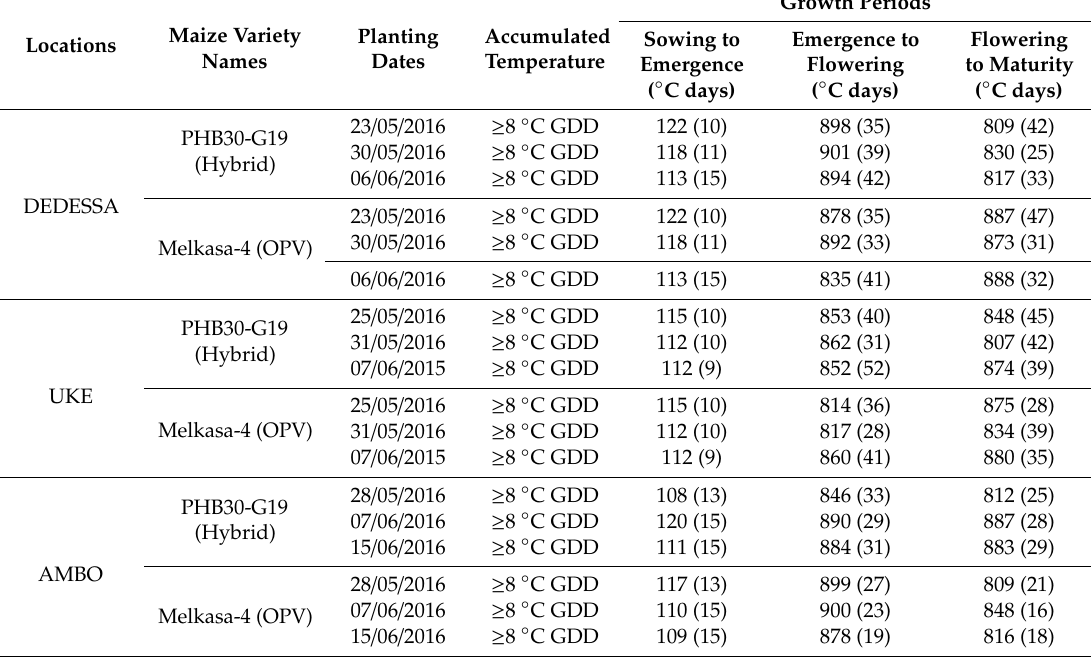
Table 1. Values of ≥ 10 ◦ C accumulated temperature and growing degree day (GDD) requirements during di ff erent growth periods with 3 planting dates for 2 maize varieties (PHB30-G19 and Melkasa-4) planted in 3 locations (DEDESSA, UKE, and AMBO) in